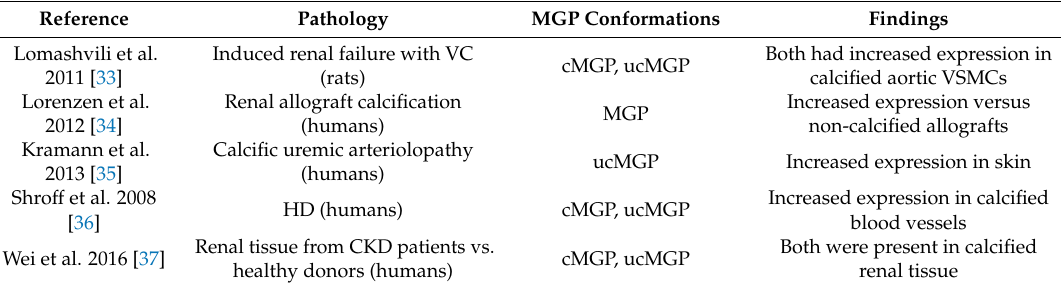
Table 4. Assessment of MGP in tissues.